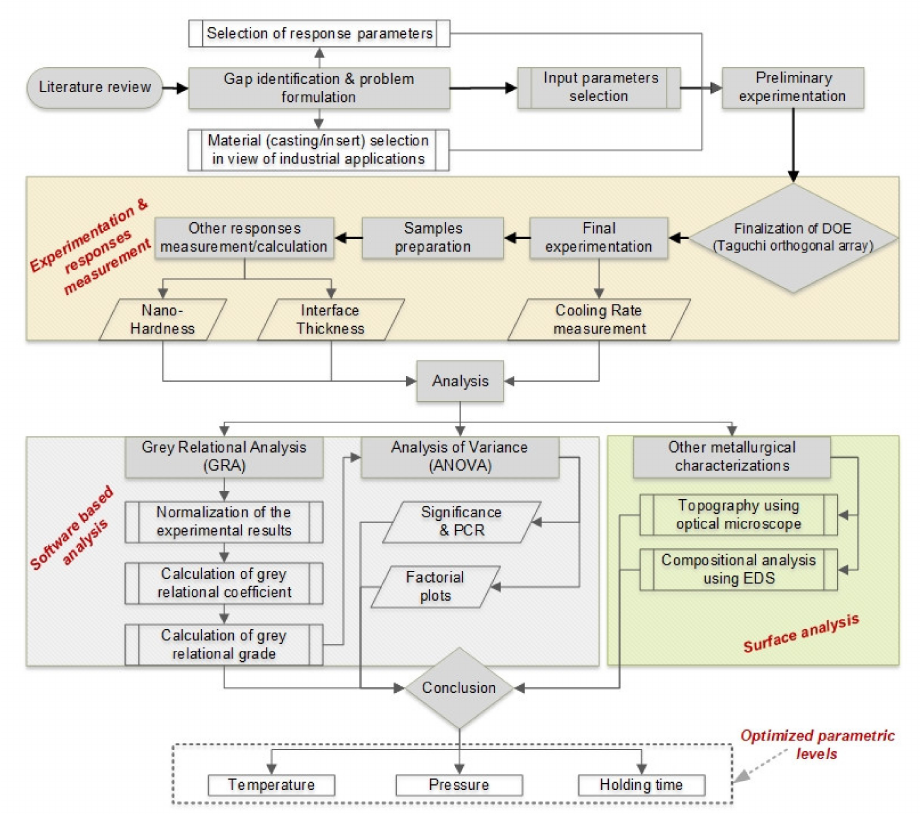
Figure 4. Research